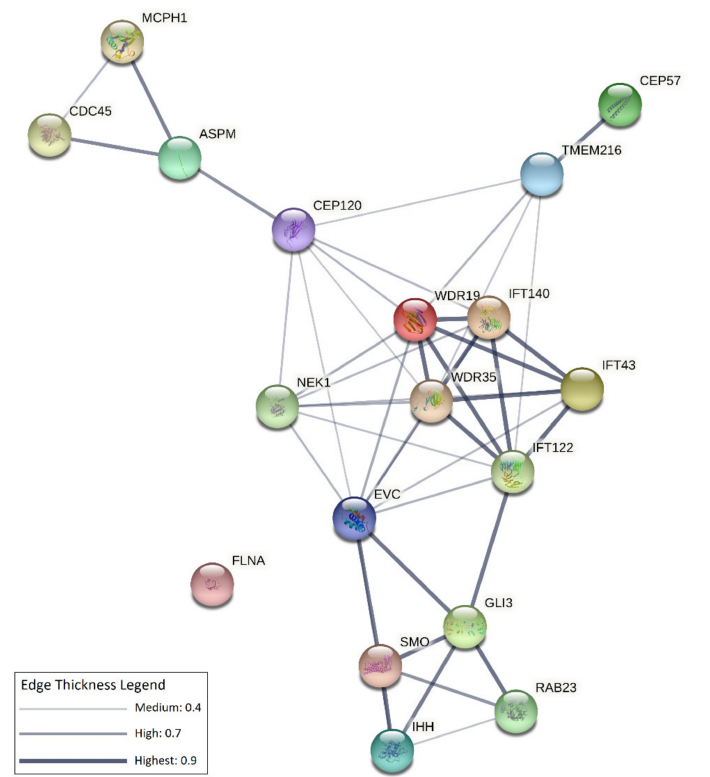
Figure 2. Network of interactions among CS-associated ciliary genes. The network was obtained using the STRING (v.11.0) software (https://string-db.org/, accessed on 8 July 2021), which assigns scores, and integrates protein–protein interaction data and complements these with computational predictions [92]. Each node in the network represents a protein/protein-coding gene, edges represent protein–protein interactions that can be either derived from curated databases, or experimentally determined, or based on computational predictions (gene neighbourhood, gene fusions, gene co- occurrence), or derive from alternative publicly available sources of information (text-mining, co- expression, protein homology). All genes implicated in ciliary functions, listed in Table 1, were used as inputs for building the network. The resulting network contains 18 interconnected nodes. The line thickness indicates the strength of data support (see the legend in the upper right side of the figure and refer to String version 11.0 https://string-db.org/ (accessed on 8 July 20) for additional